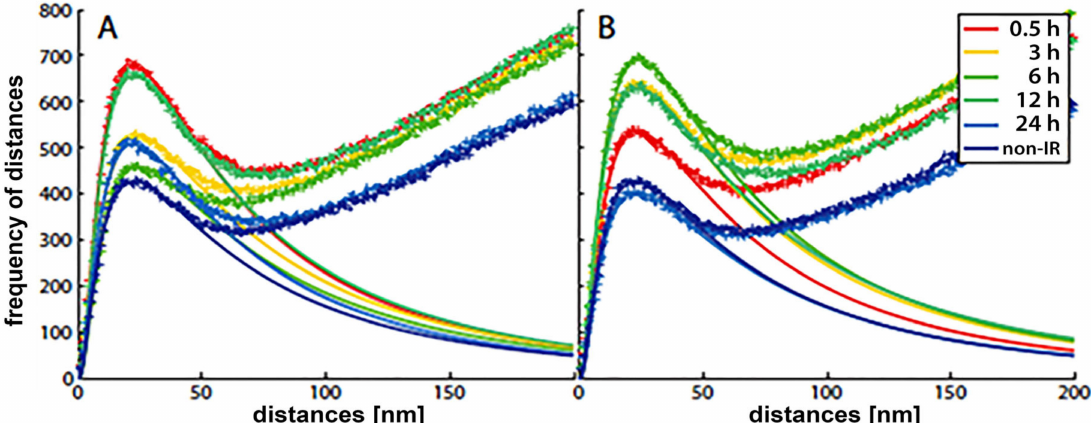
Figure 7. Frequency histograms of pairwise distances of H3K9me3 heterochromatin label points in breast cancer cell (SkBr3) nuclei at different times post irradiation with two doses of X-rays: ( A ) 500 mGy, ( B ) 4 Gy. The distributions of the crosses represent the experimentally measured results. The smooth curves, which follow a logarithmic Gaussian distribution, are fitted curves of the peaks below 100 nm, indicating cluster formation in heterochromatin. According to Ripley’s interpretation, the linearly increasing experimental curves describe a random behavior of molecule positions, i.e., the dense clusters are embedded in an environment of randomly, less densely arranged H3K9me3 marks. Non-IR: the nonirradiated